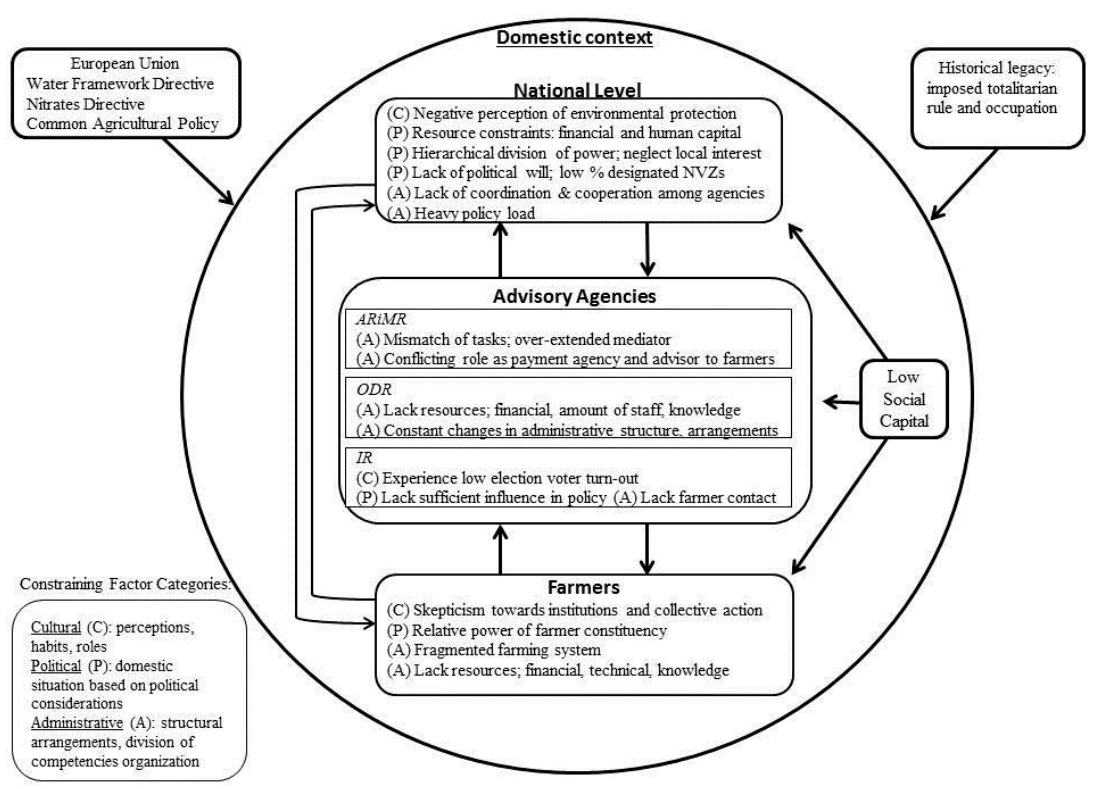
Figure 5. Interplay of the constraining factors that shape the nitrate management discourse.